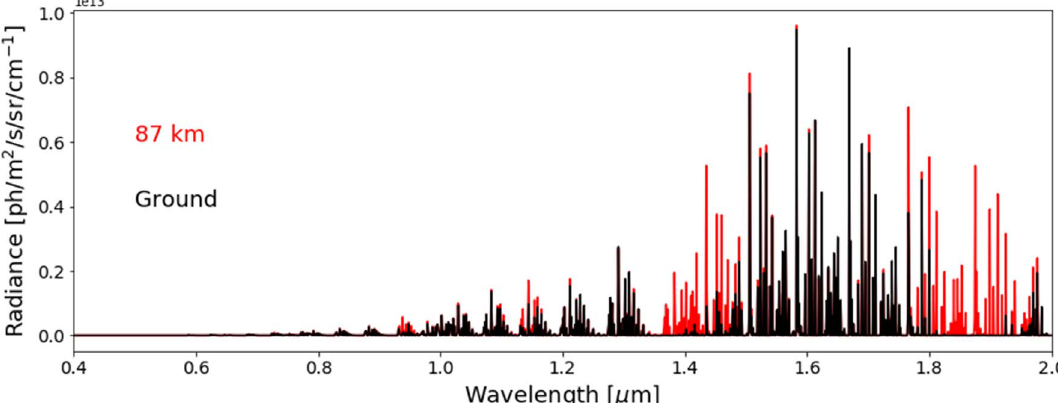
Fig. 1. Example of a spectrum at 87 km (in red) and the same spectrum propagated at the ground level (in black). We notice the strong water vapor absorption band around 1.4